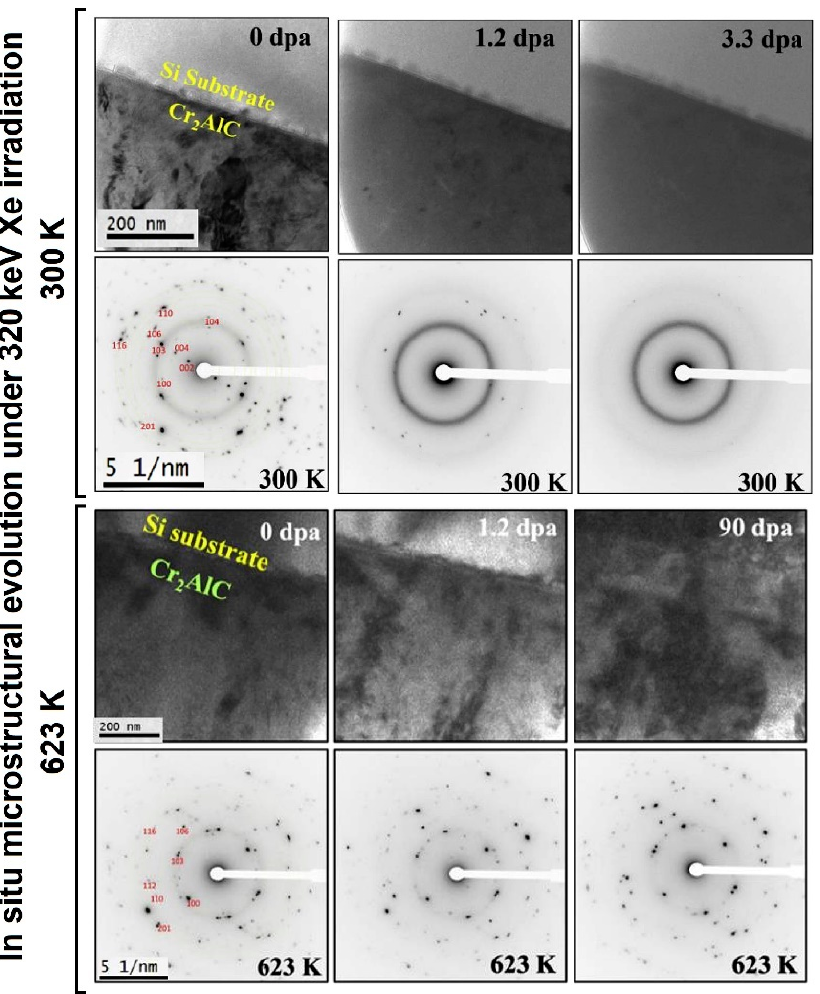
Figure 11. Evolution of microstructure of magnetron-deposited Cr 2 AlC thin film under 320 keV Xe irradiation at 300 and 623 K. Reproduced from [160] with permission by Elsevier.